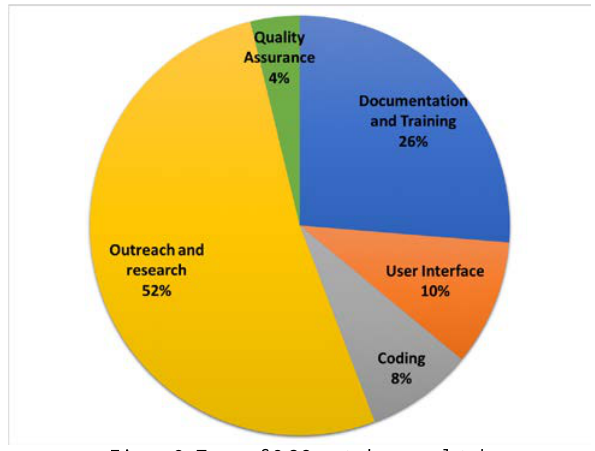
Figure 3. Type of OSGeo tasks completed